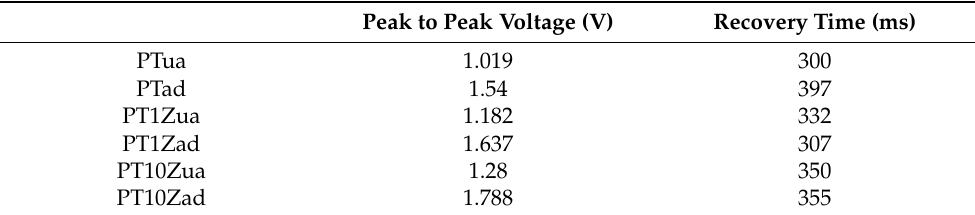
Table 3. Peak-to-peak voltage table.